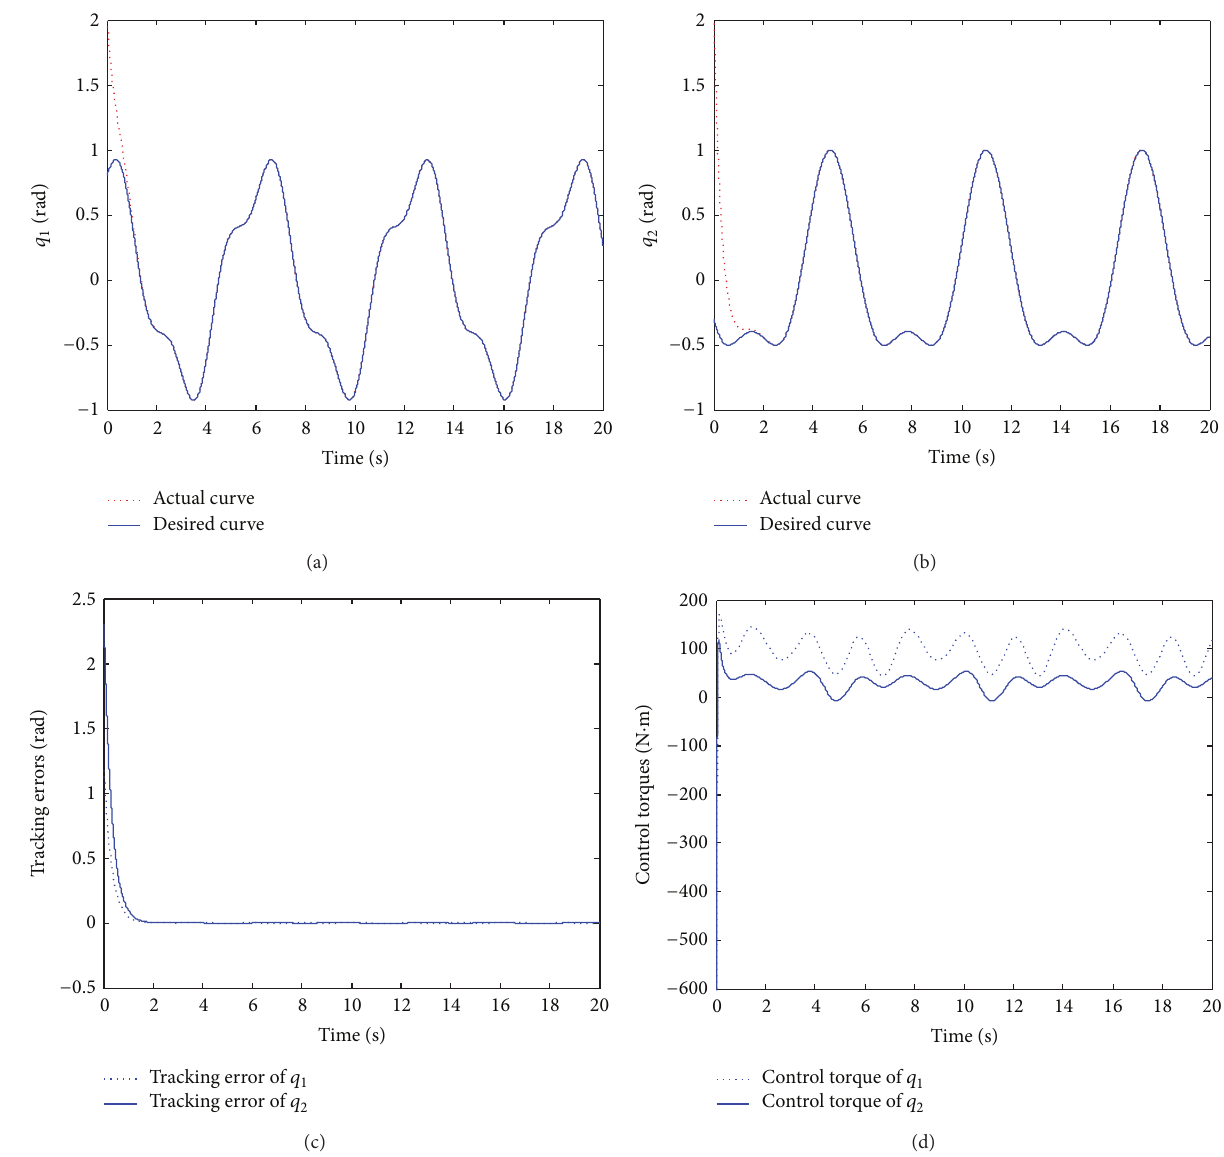
Figure 2: CTC for robotic manipulator without uncertainties and disturbances. (a) Tracking curve of 𝑞 1 , (b) tracking curve of 𝑞 2 , (c) tracking errors, and (d) control